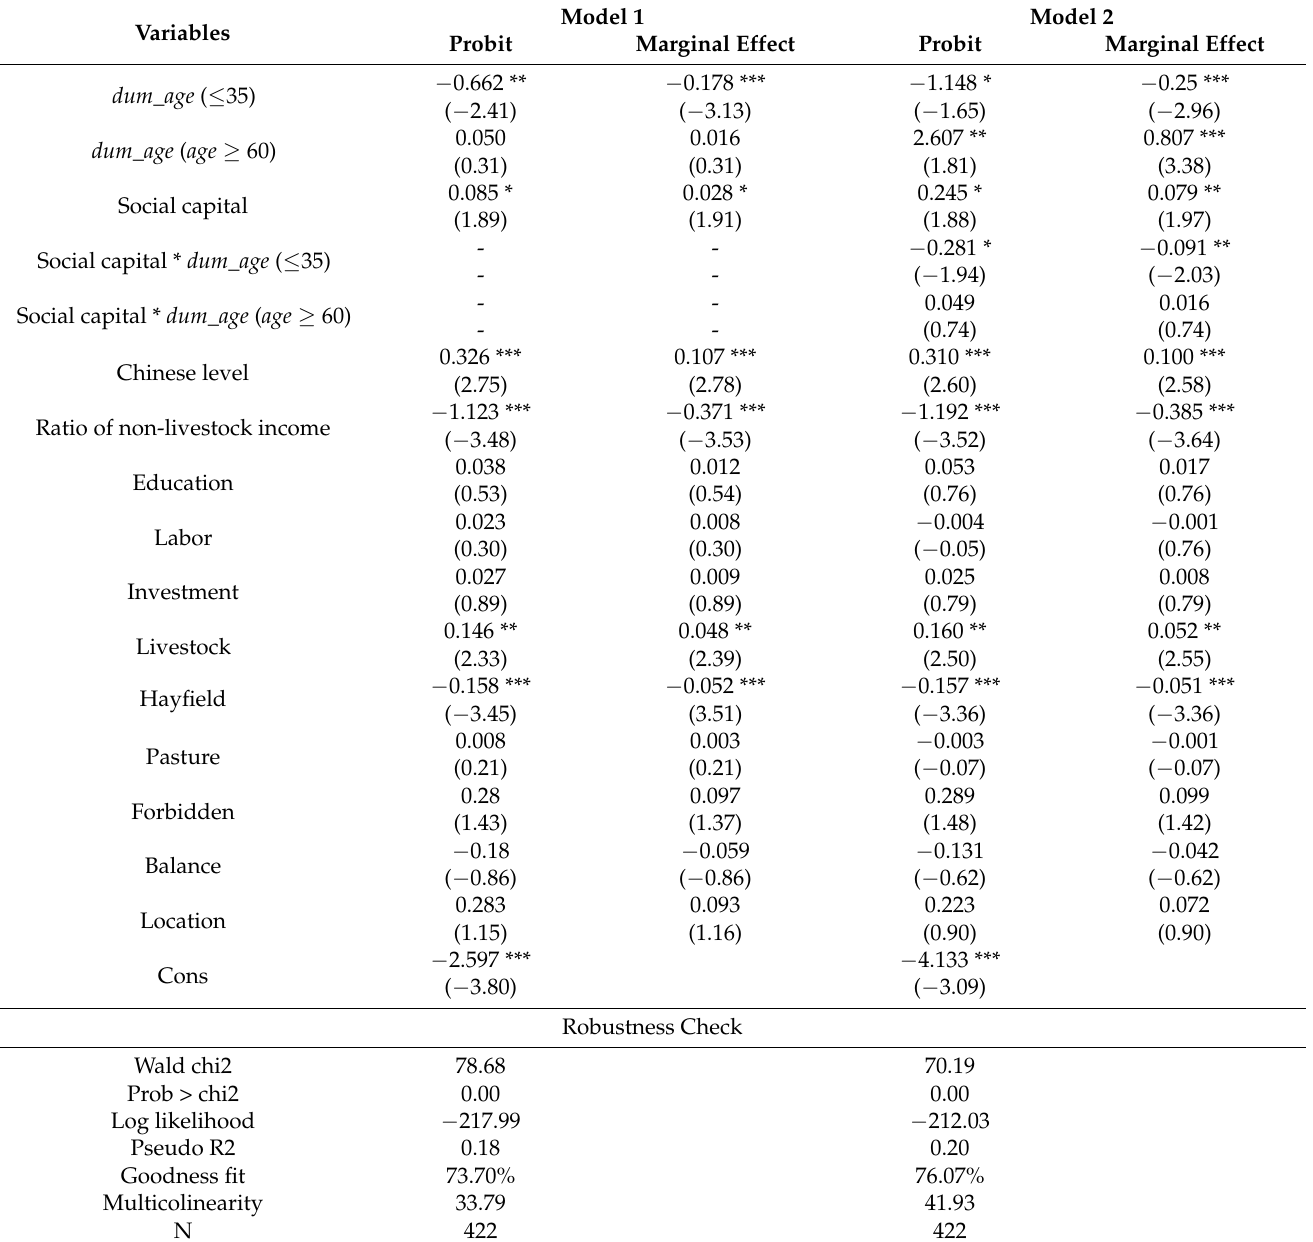
Table 6. Results of the Probit model evaluation with robust and marginal